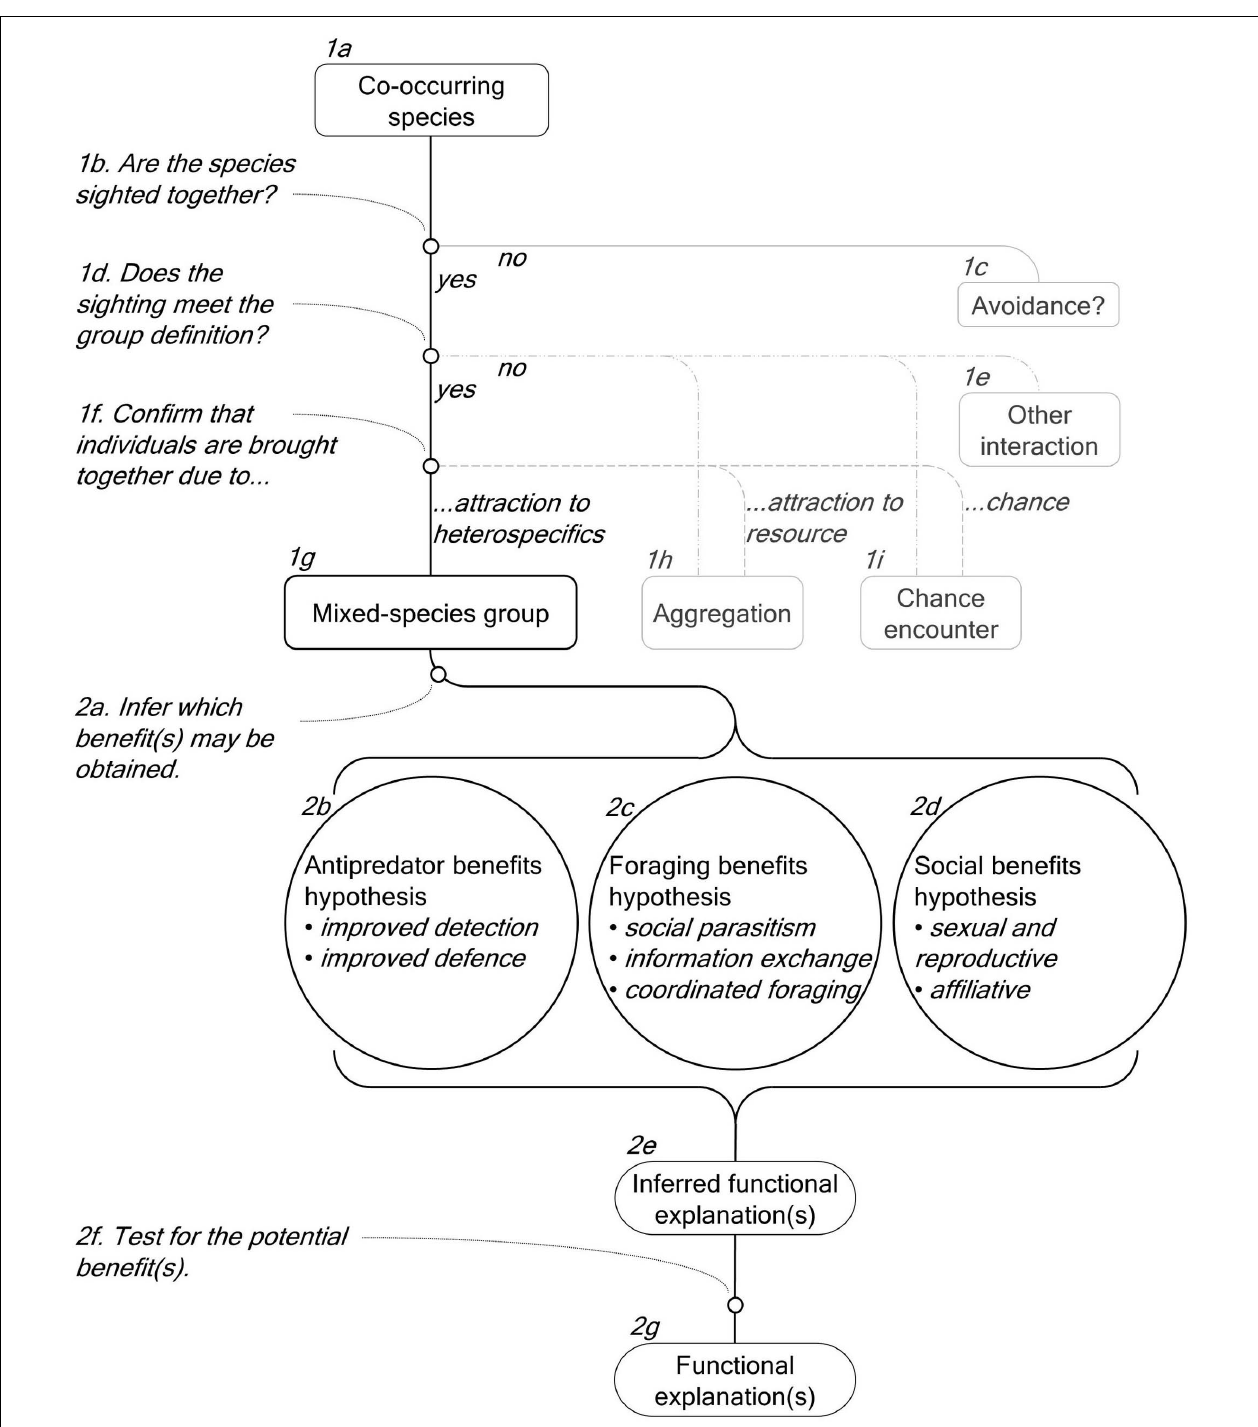
FIGURE 6 | A conceptual framework for studying cetacean mixed-species groups (MSGs). The framework details the steps required to determine that the species form a MSG (Boxes 1b, 1d, and 1f) and to establish the potential function(s) of the MSG (Boxes 2a and 2f).